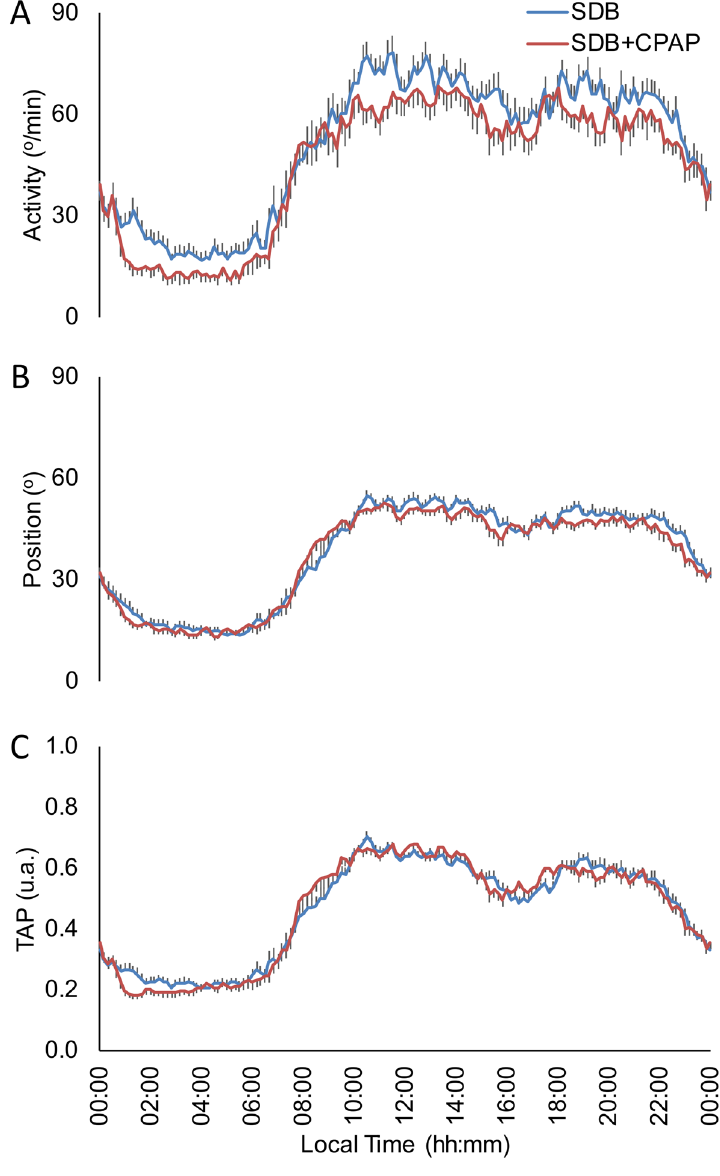
Figure 5. Circadian patterns for 18 SDB subjects at baseline (SDB, red line) and after 6 months of CPAP treatment (SDB + CPAP, in blue). ( A ) Activity (º/min), ( B ) Body Position (º) and ( C ) integrated variable TAP (a. u.). All data are expressed as mean ±